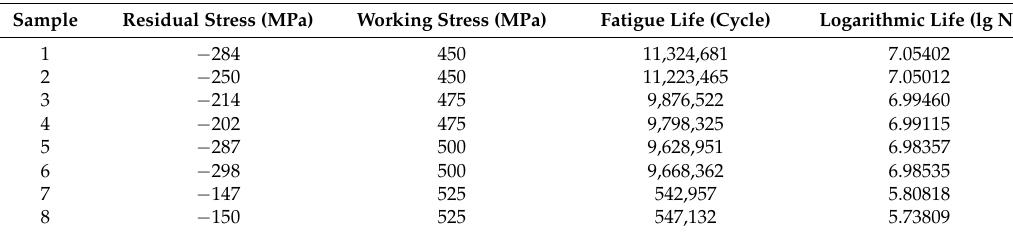
Table 3. Fatigue life of specimens with different surface integrity and stress